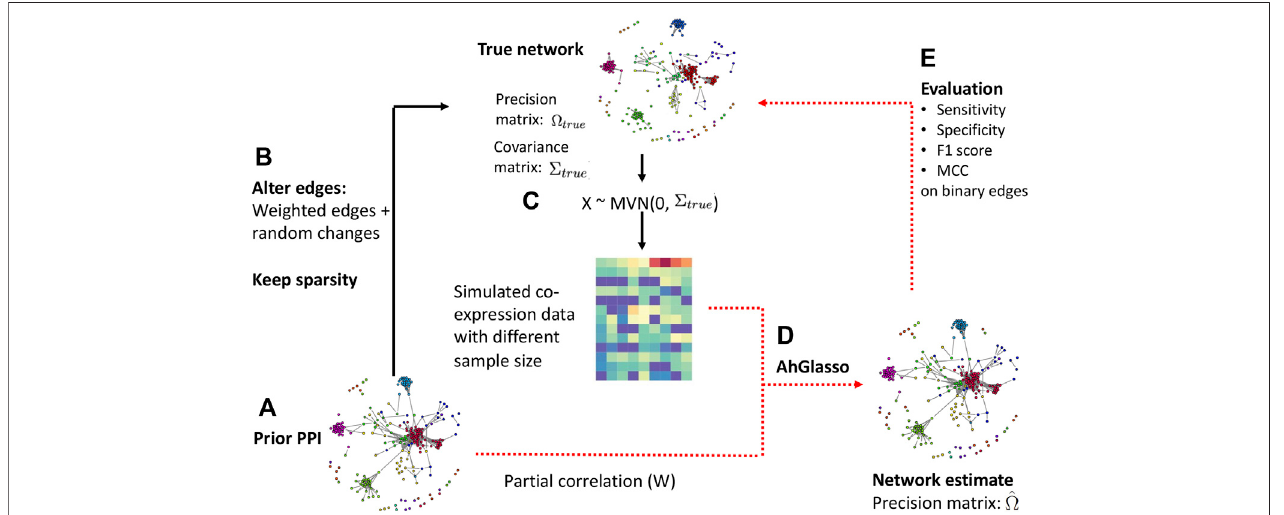
FIGURE1| Flowchartofdatasimulationandmethodevaluation.Step (A) :ascale-freepriornetworkwasbuiltbyinputtingthenodenumberp(graphsize).Withthe priorscale-free networkandits precisionmatrix Ω ,thepartial correlation canbe calculated. Theabsolutevalueofpartialcorrelationserves asprior knowledge (prior PPI) for upcoming simulations. Step (B) : we altered network connections by adding random changes but the sparsity was kept at a similar level unless otherwise speci fi ed. Strong nodeconnectionswerelikelykeptduetotheirhigher absolutevalueintheprecisionmatrixandwerelesslikelytobecome0.Step (C) :withaltered precision matrix ( Ω true ) and its corresponding covariance matrix ( Σ true ), we simulated expression data X n × p ∼ N (0, Σ true ). Of note, we ensured the covariance matrix to be positive de fi nitebasedontheFrobeniusnorm.Step (D) :incorporatingpriorPPIandsimulateddataset,weestimatedthetargetnetwork(i.e.,adjacencymatrix)withourproposed method. Step (E) : the prediction performance was evaluated with sensitivity, F1 score, and